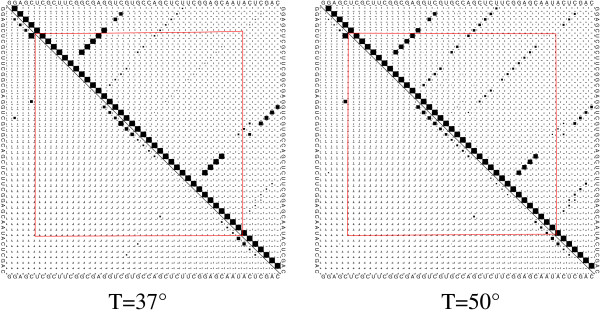
Comparison between the base-pair probabilities and the distance importance I6,42(e). The base-pair probabilities (upper-right-triangle) and the distance importances I6,42(e) (lower-left-triangle) of backbone edges and base pairs between 6(U) and 42(U) of DAse ribozyme (Figure 2) are computed at temperatures 37°C and 50°C, repectively. The size of the squares is proportional to the probability/value. The region covered by the between 6(U) and 42(U) is annotated by a red rectangle. For ease of comparison, backbone edges are added to the base-pair probability matrix.